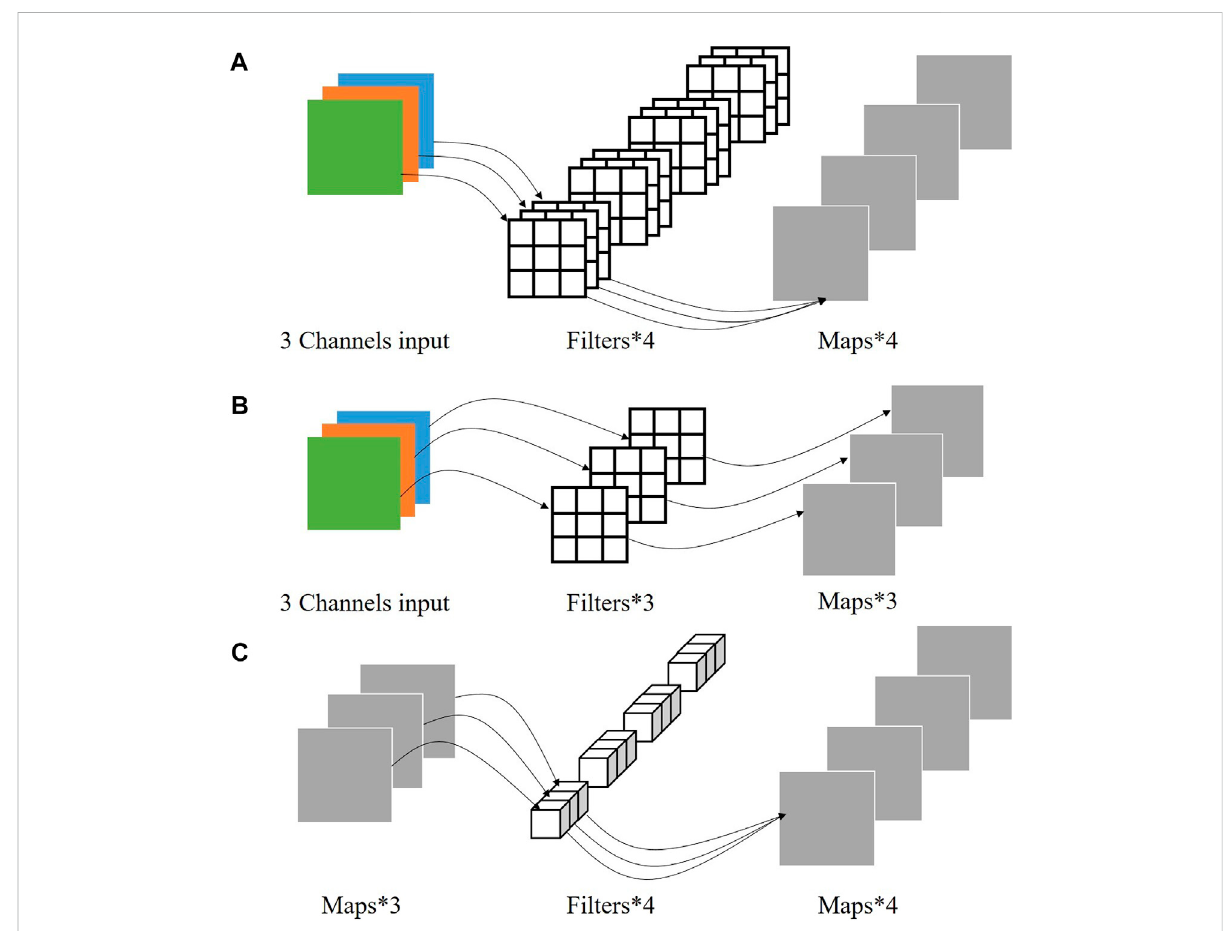
FIGURE 2 (A) Standard convolution; (B) depthwise convolution; and (C) pointwise